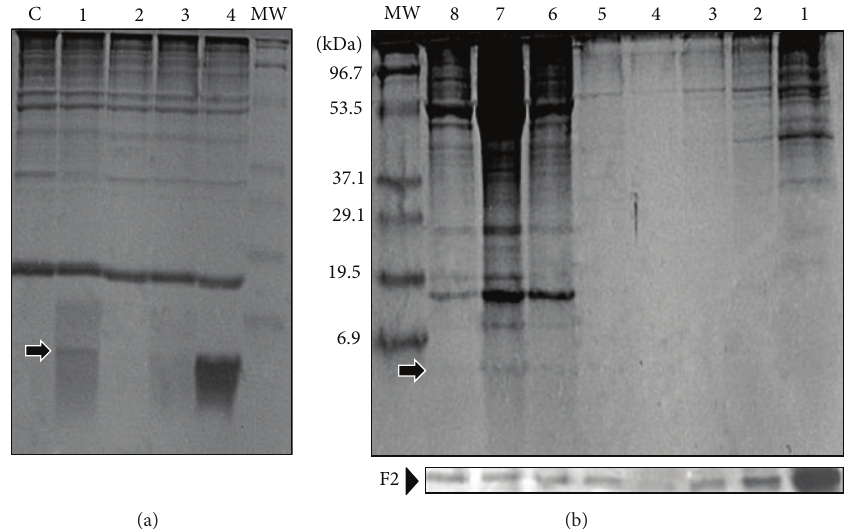
Figure 5: Tris-Tricine electrophoretic identification of hTip-CSKH or control peptides. (a) 10 𝜇 g of the indicated peptides (1 = hTip-CSKH; 2 = hTip; 3 = hTip-CSKH-Scr; 4 = CSKH) was mixed with 10 𝜇 L of a protein extract of red blood cells membranes. The gel was stained with Coomassie Brilliant Blue. The size of each molecular weight marker (MWM) is indicated in the right and the control (c) membranes without peptides in the left. The arrow indicates the band corresponding to hTip-CSKH molecular weight. (b) The membrane extract from hTip-CSKH-treated human PBMC was resolved by ultracentrifugation in a sucrose density gradient. Eight fractions were recovered as indicated in each line. Half of each fraction was used for Tris-Tricine electrophoresis for hTip-CSKH identification (the arrow marks the band corresponding to hTip-CSKH molecular weight). The remaining amount of the fraction was used for WB blot in order to know its Flotillin 2 content (bottom) and to differentiate between light (lanes 1–3) and heavy (lanes 5–8) fractions. The size of each molecular weight marker (MWM) is indicated in the